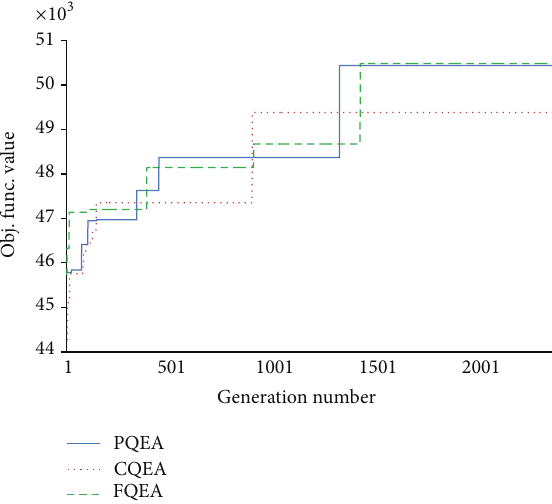
Figure 40: Convergence graph of PQEA, CQEA, and FQEA on 0-1 knapsack problem with circle data instances with number of items, 𝑀 , being 5000 and capacity, 𝐶 , being 2% of total weight.